Question: In a single sentence, describe what this figure presents.
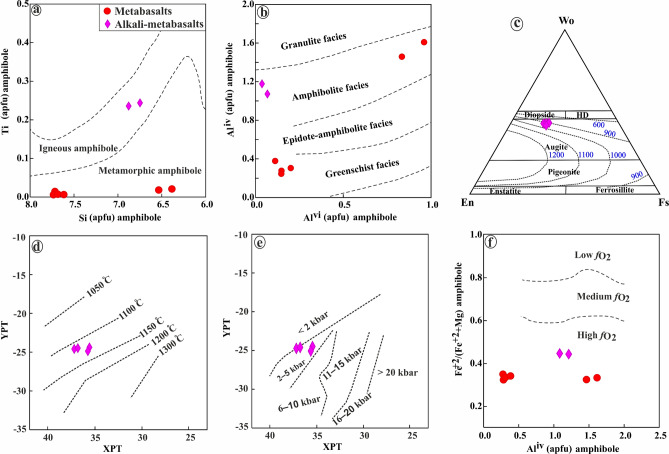
Answer: ( a ) Si vs. Ti discrimination diagram of amphiboles 84 , ( b )Al iv vs. Al vi bivariate discrimination diagram of amphiboles 94 , ( c ) Wo-En-Fs nomenclature diagram of Cpx 85 . The isothermal dotted lines are after Stormer 95 , ( d, e ) XPT–YPT diagram for estimating formation temperature and pressure of Cpx 99 , ( f ) Al iv vs. Fe +2 /(Fe +2 + Mg +2 ) for oxygen fugacity estimation of amphiboles ( fO 2 ) 102 . This figure is created by the Igpet 2010 software ( https://www.rockware.com/product/igpet/ ).